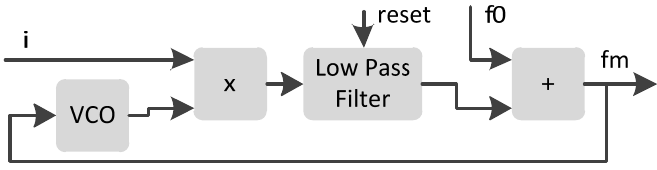
Figure 6. Block diagram of the Tracking Frequency. VCO: Voltage Controlled Oscillator.